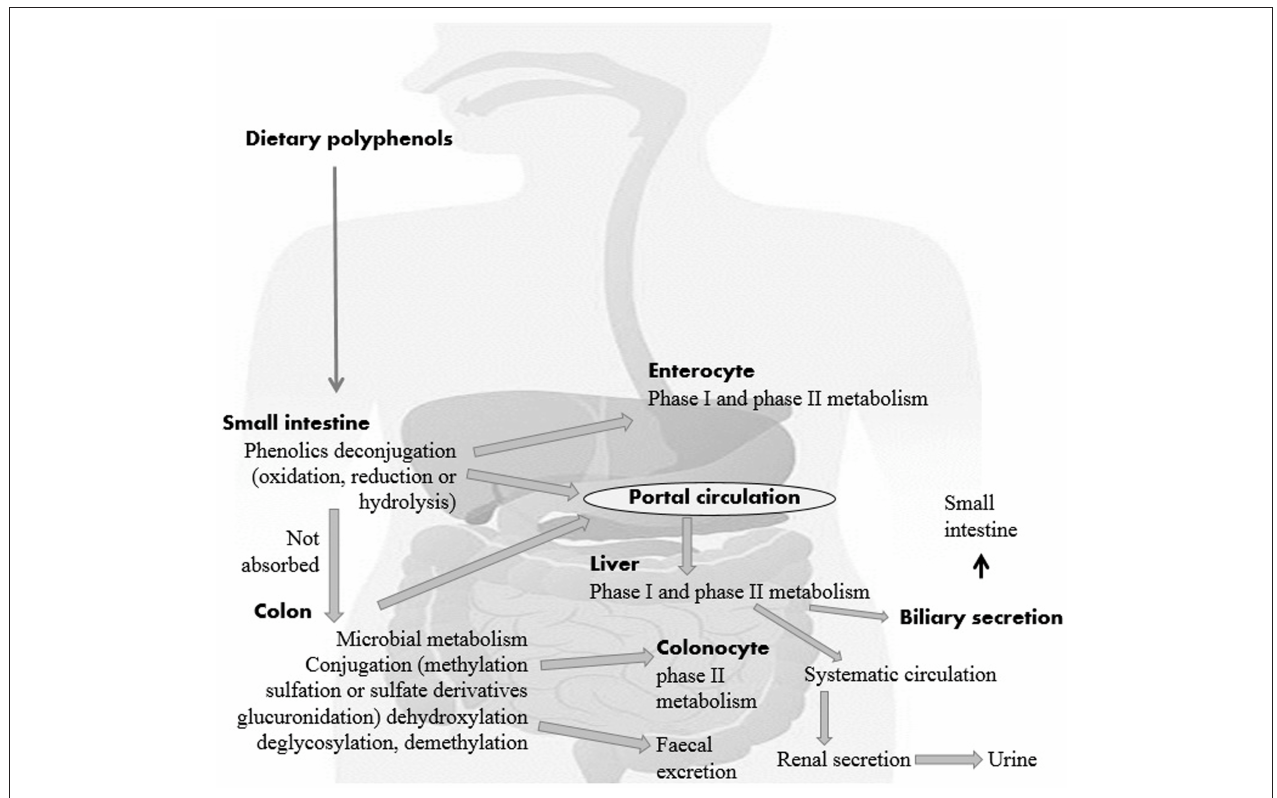
FIGURE 2 | Dietary polyphenols and its